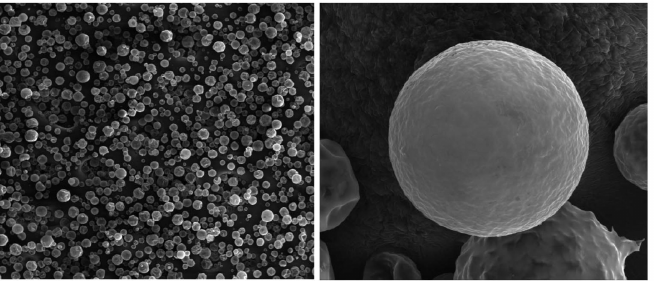
Figure 4. Optical microscopic images of produced microcapsules; with permission from ASCE